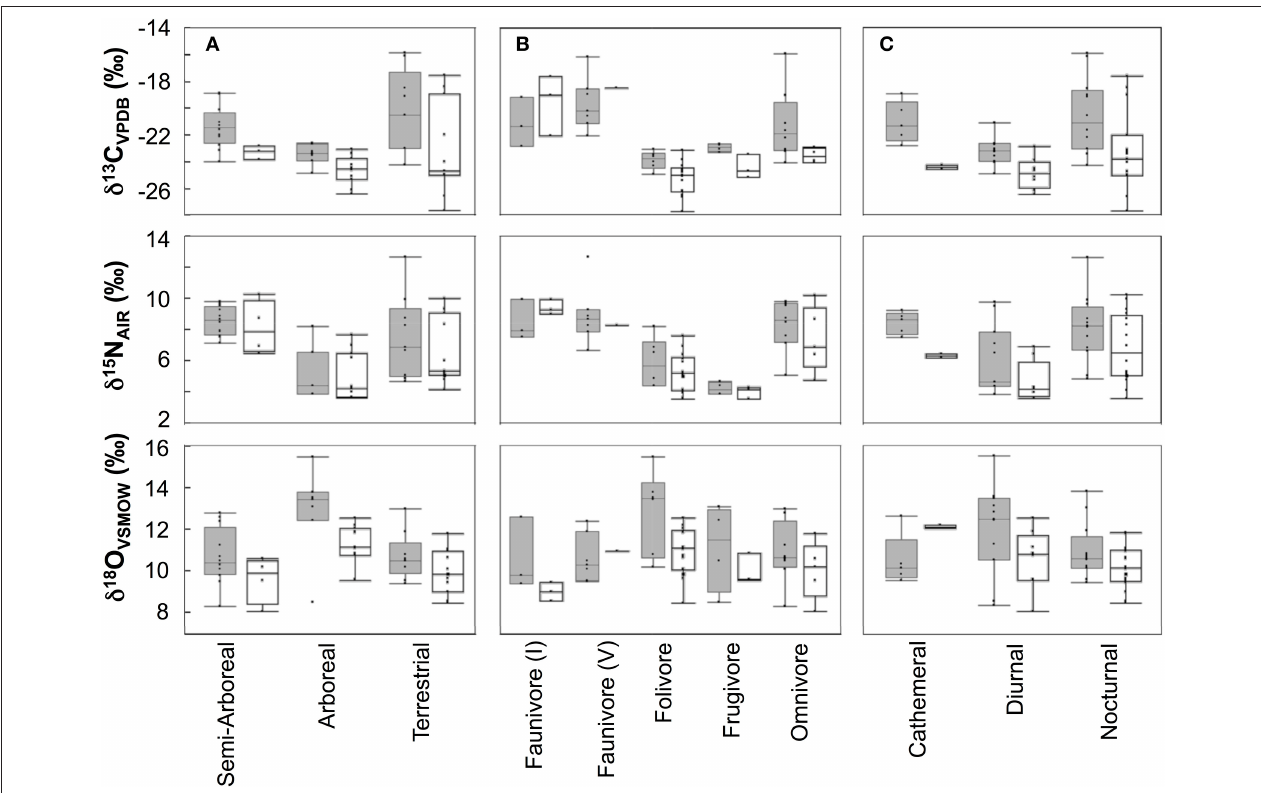
TABLE 4 | Planned contrast results for collagen isotopes. Isotope Contrast df Contrast SS F -value P (one tailed) Carbon Primary vs. Secondary Consumer 1 104.01 Arboreal vs. Terrestrial Diurnal vs. Nocturnal Nitrogen Primary vs. Secondary Consumer Arboreal vs. Terrestrial Diurnal vs. Nocturnal Oxygen Primary vs. Secondary Consumer 1 Arboreal vs. Terrestrial Diurnal vs.